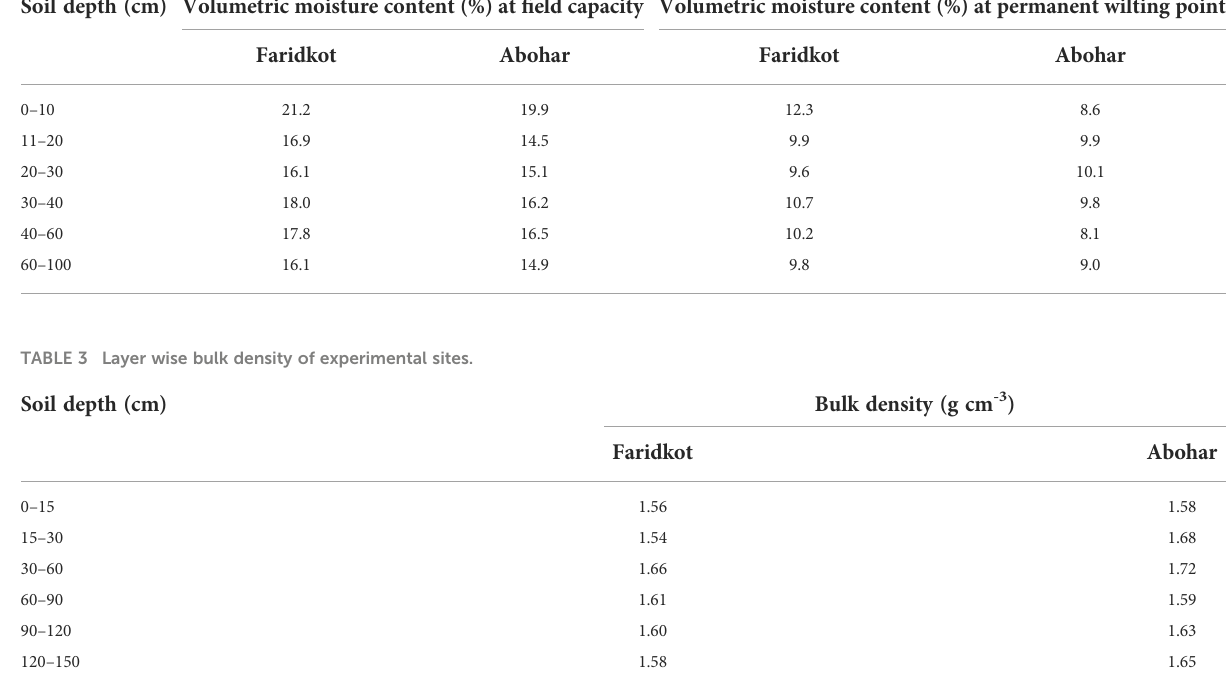
TABLE 2 Layer-wise moisture retention capacity of soil at the experimental sites.